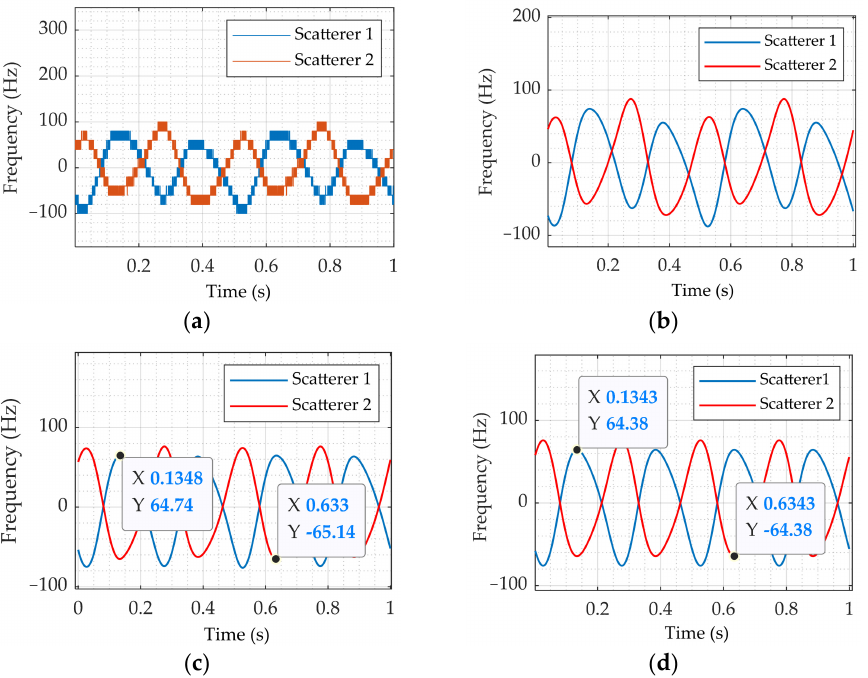
Figure 6. The final micro-Doppler curves of the proposed method. The results after the curves subtraction ( a ); The results after smoothing ( b ); The final micro-Doppler curves ( c ); The theoretical final micro-Doppler curves ( d ).